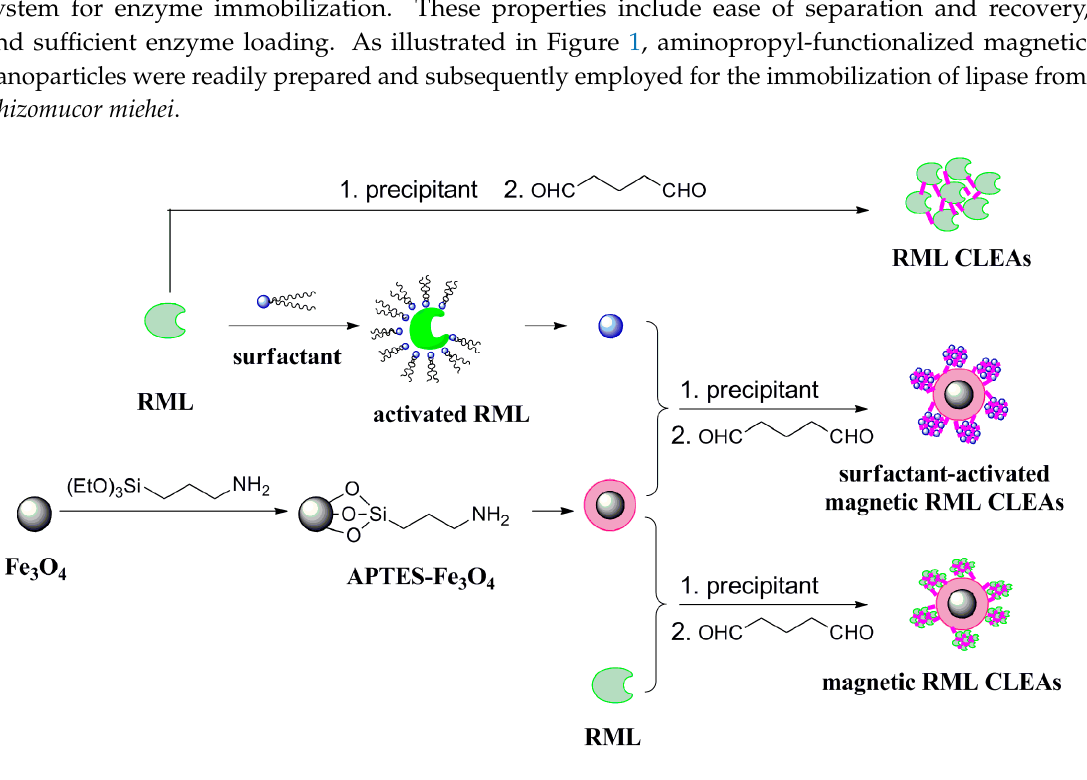
Figure 1. Schematic illustration of the immobilization process to produce Rhizomucor miehei (RML) cross-linked enzyme aggregates (CLEAs), magnetic RML CLEAs, and surfactant-activated magnetic RML CLEAs.